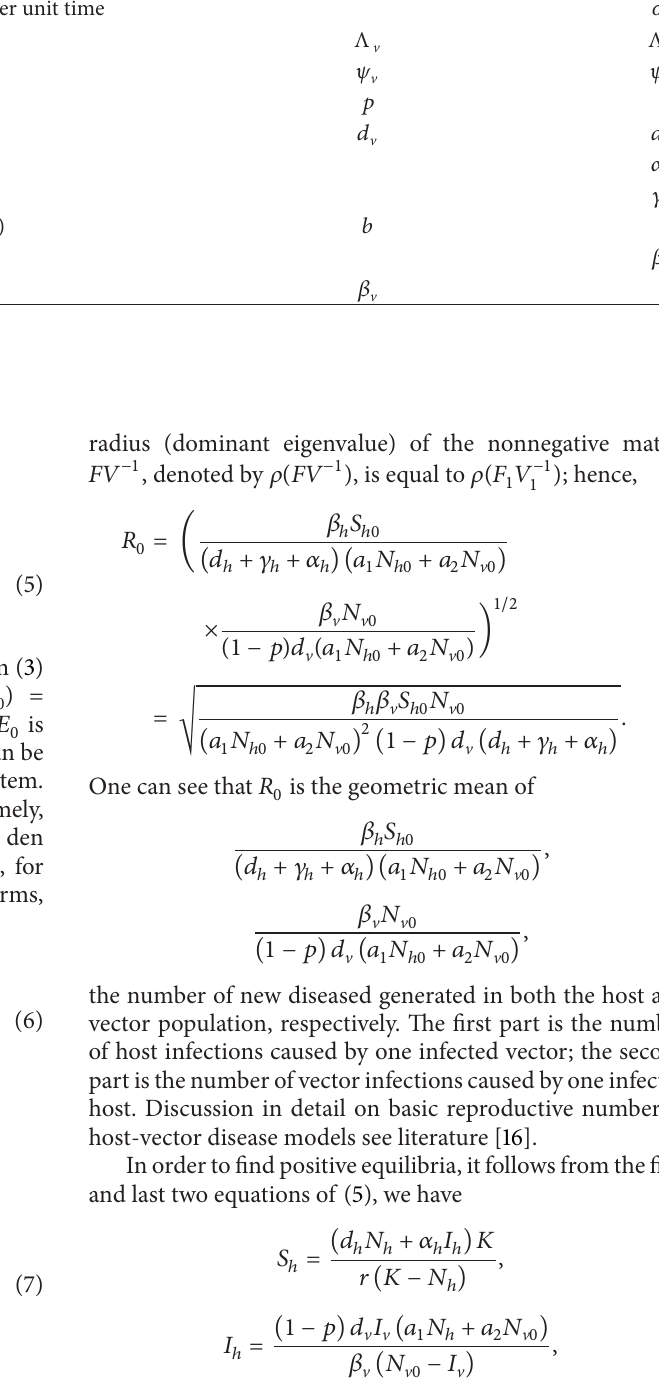
Table 2: Parameters involved in the models for the dynamics of vector-borne diseases. Parameters in the models Vector Host Per capita birth rate 𝜆 V 𝜆 ℎ The fraction of the infective immigrants Number of times one mosquito would want to bite humans per unit